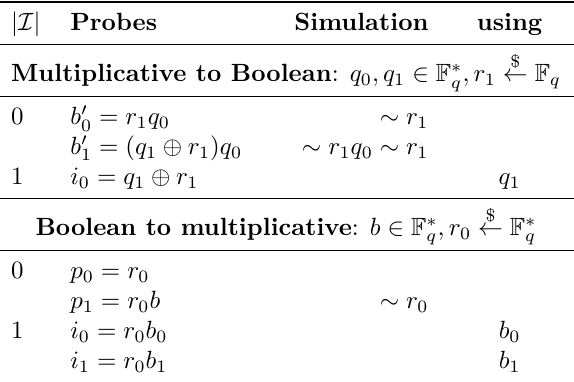
Figure 16: First-order Boolean to multiplicative (left) and multiplicative to Boolean (right) conversion circuits with intermediate probes Table 6: Simulation of intermediate probes I and output probes O such that |I| + |O| ≤ d = 1 using |I| input shares for the first-order